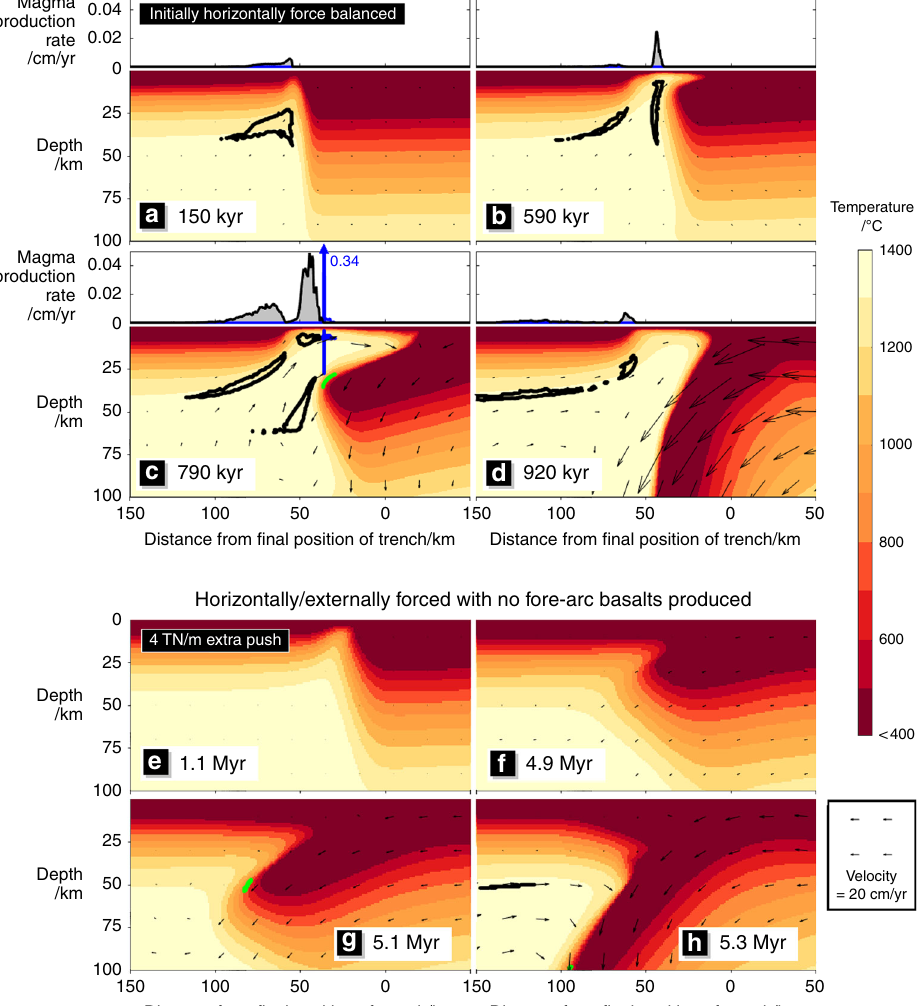
Fig. 2 Models of vertically and horizontally driven subduction initiation. Temperature pro fi les in a – d : the model displaying vertically driven subduction initiation (taken at 150, 590, 790 and 920 kYrs from the start of the model run); e – h : the model displaying horizontally forced subduction initiation (taken at 1.1, 4.9, 5.1, 5.3 Myr from the start of the model run). Overlain are: regions where decompression melting is occurring (black outline); where melting is occurring in the presence of slab fl uid (blue outline) and the region of the subducting crust which has crossed its solidus (green outline). Above each pro fi le (for the vertically driven model only, a – d ) is the eruption rate of decompression melts, assuming that all melt is extracted and travels vertically to the